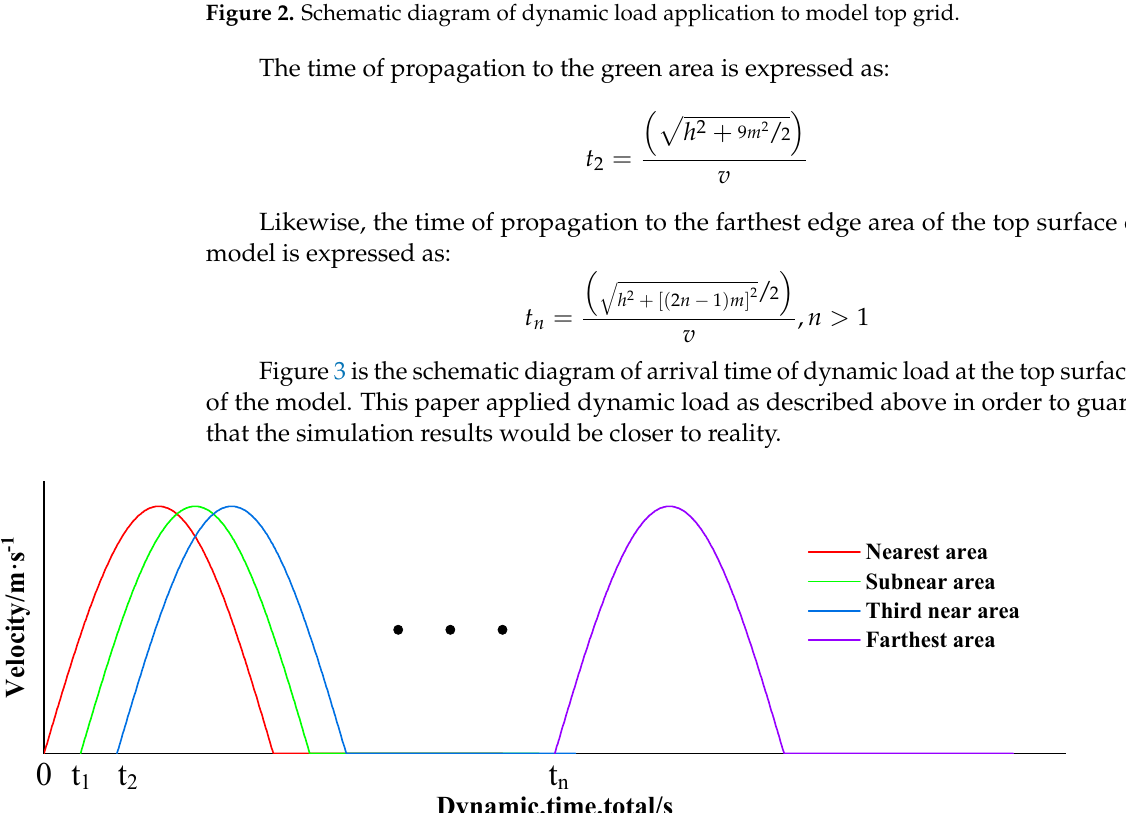
Figure 3. Schematic diagram of arrival time of applied dynamic load.